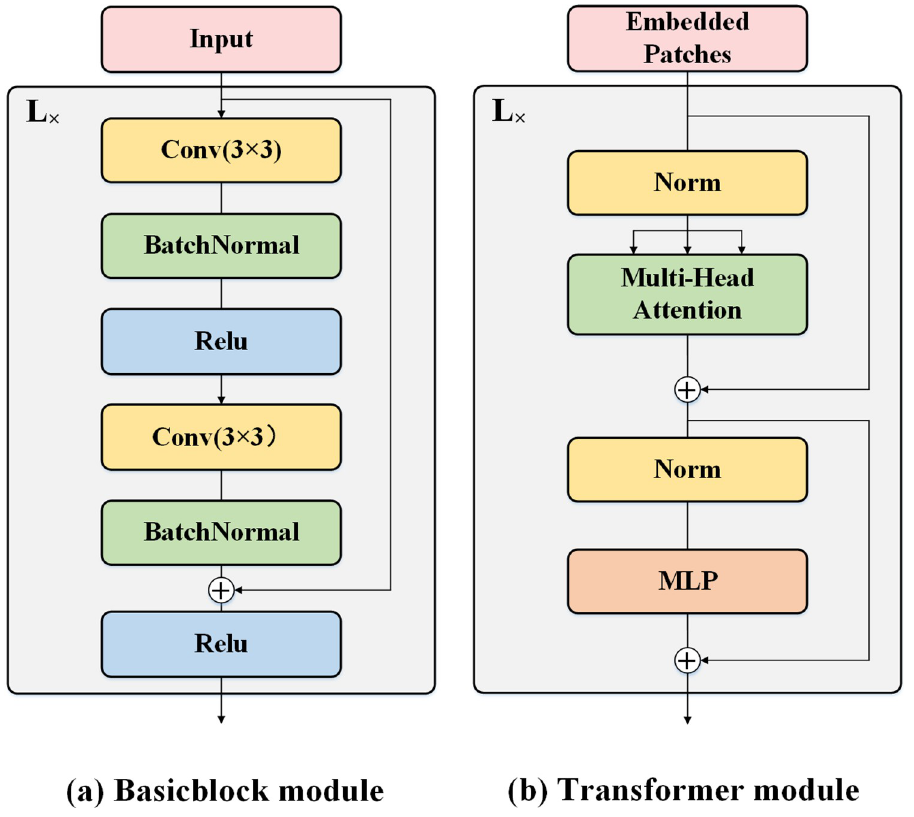
Fig 4. Convolutional modules and transformer modules. (a) Basicblock module and (b) Transformer